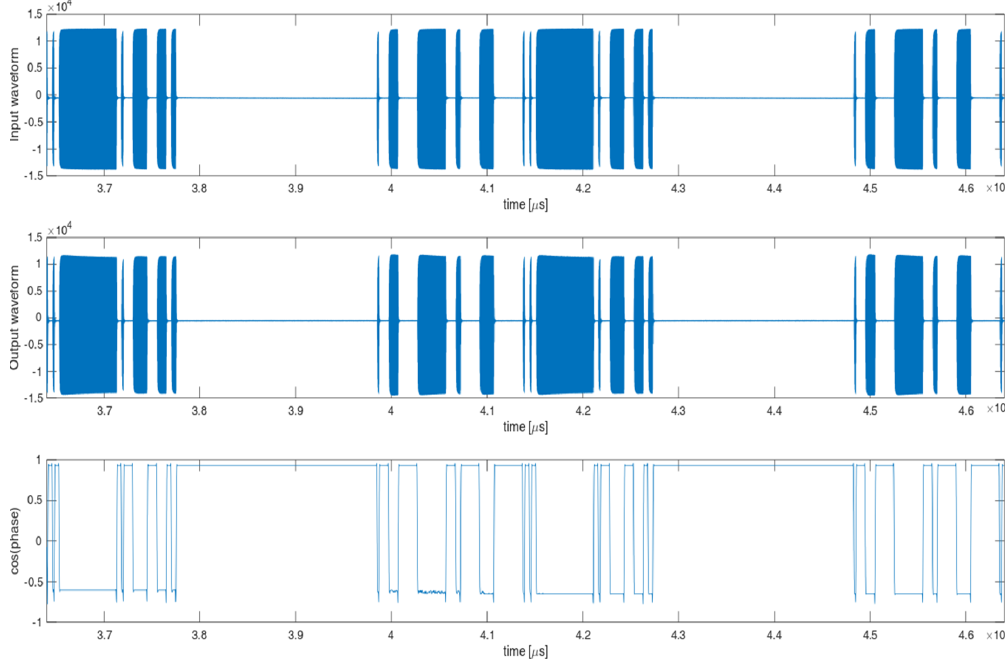
Figure 6. Sample measurement results: input waveform, output waveform and phase difference between waveforms above.